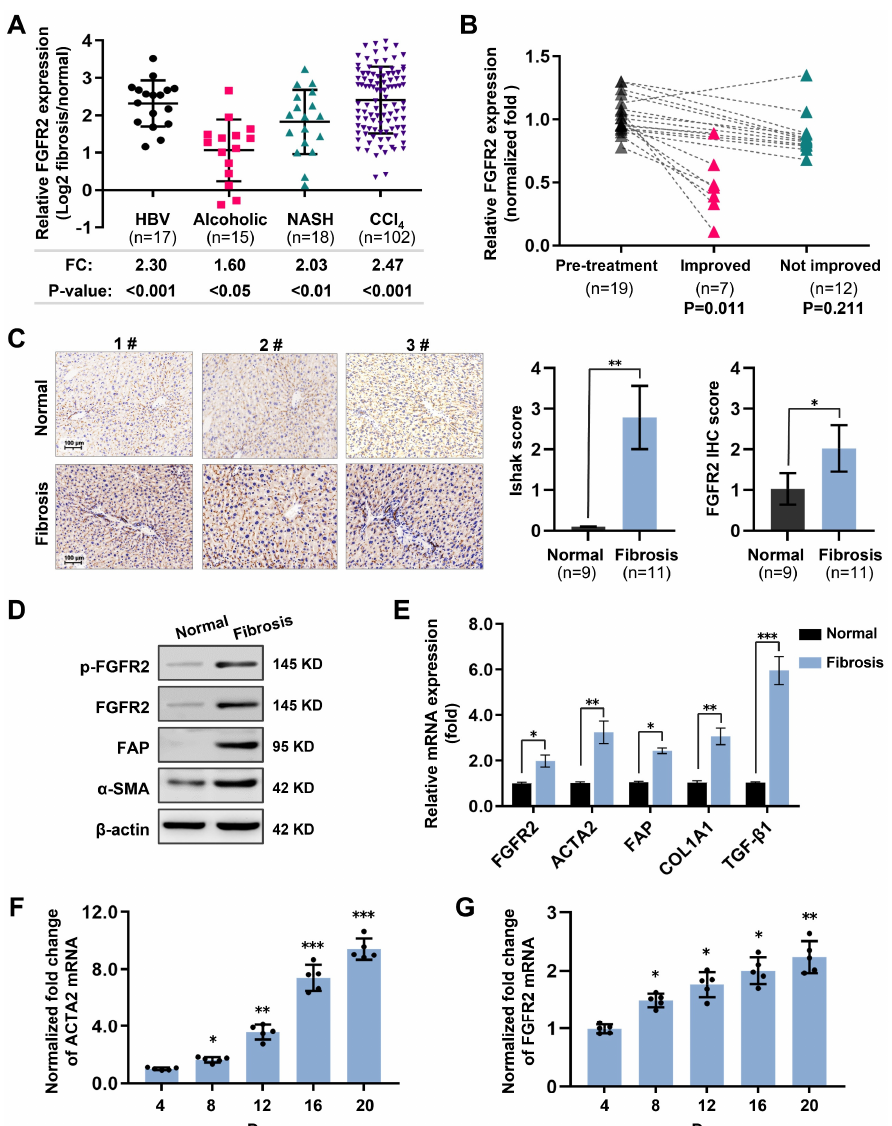
Figure 1. High expression of fibroblast growth factor receptor 2 (FGFR2) coincides with liver fibrosis. ( A ) The expression of FGFR2 in fibrotic liver and normal liver tissues was evaluated through data mining of human samples affected by Hepatitis B infection (GSE38941), alcohol abuse (GSE28619), and nonalcoholic steatohepatitis (GSE48452), as well as mouse samples induced with carbon tetrachloride (CCl 4 ) (GSE152329, GSE98577). The differential fold expression was determined by comparing the expression of FGFR2 in the fibrotic liver and normal liver tissues. ( B ) A comparison of changes in FGFR2 expression in liver fibrosis patients in remission (improved) or not in remission (not improved) with mining data of GSE175448. ( C ) The correlation between FGFR2 expression and the liver fibrosis score (Ishak score) was analyzed by comparing FGFR2 expression in three pairs of liver fibrotic tissues and normal liver tissues through immunohistochemistry. ( D ) FGFR2 expression in liver fibrosis tissues and normal liver tissues was verified by Western blot and ( E ) q-PCR analyses. ( E ) Liver tissues from mice treated with CCl 4 for different durations were used to determine the expression of the liver fibrosis markers Actin Alpha 2 (ACTA2) and FGFR2 by q-PCR and the trends of their expression with increasing days of induction. ( F ) The expression of ACTA2 and ( G ) FGFR2 was determined by q-PCR in liver tissues from mice treated with CCl 4 for varying durations. The statistical significance was determined based on the p -value. The results are marked as significant “*” when p < 0.05, “**” when p < 0.01 , “***” when p < 0.001, and not significant (ns) if p ≥